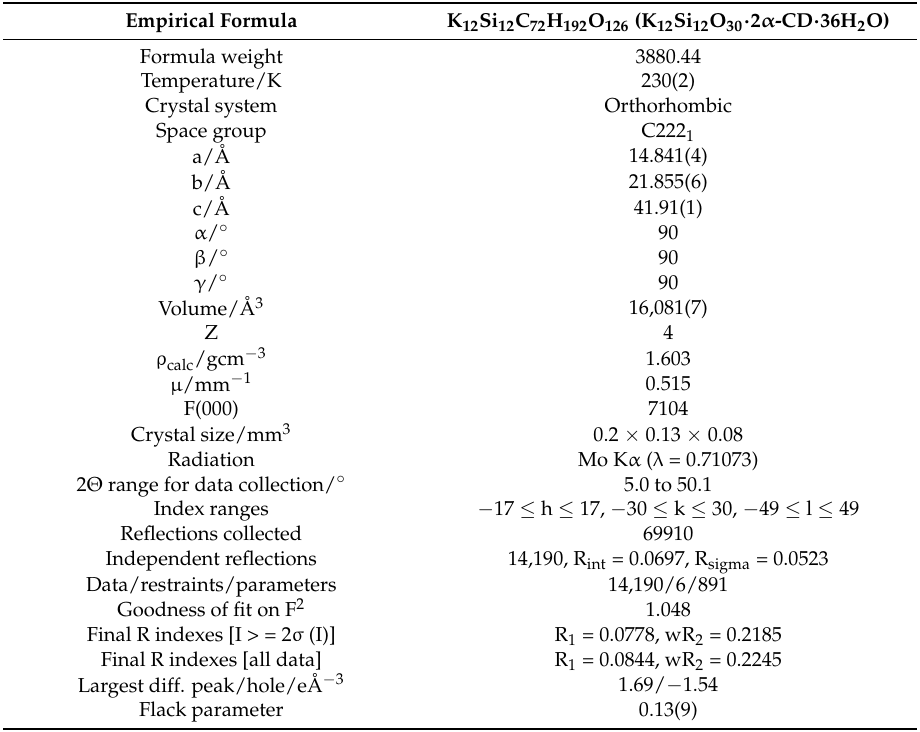
Table 1. Crystal data and structure refinement parameters for D6R@ α